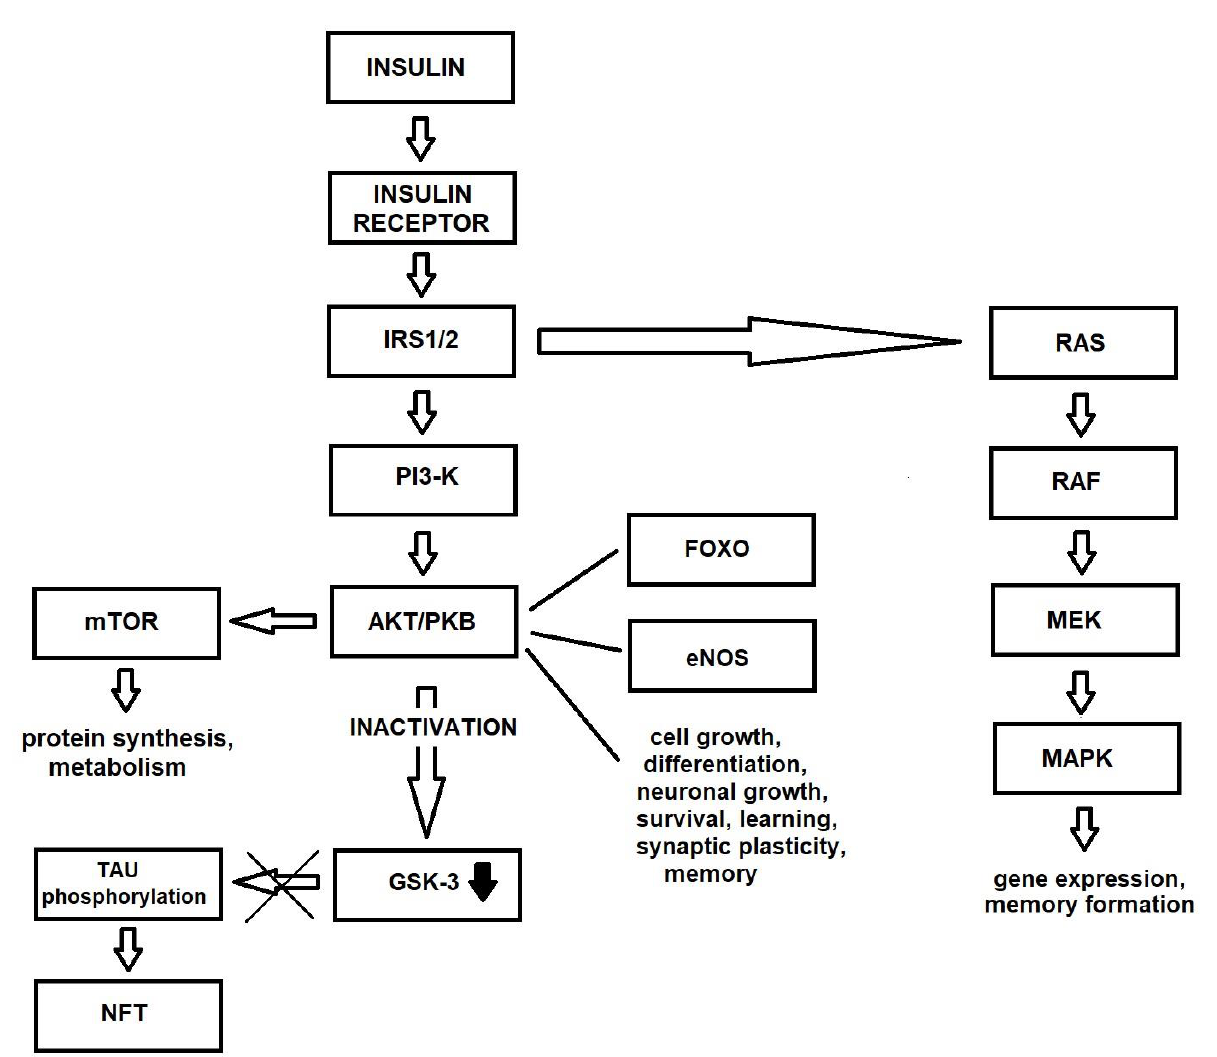
Figure 1. Insulin signaling pathway in healthy brain.